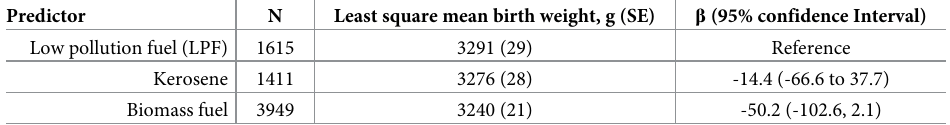
Table 5. Association between birth weight among term births and maternal use of cooking fuel type in the, 2018 Nigeria Demographic and Health Survey (N = 6975). Predictor N Least square mean birth weight, g